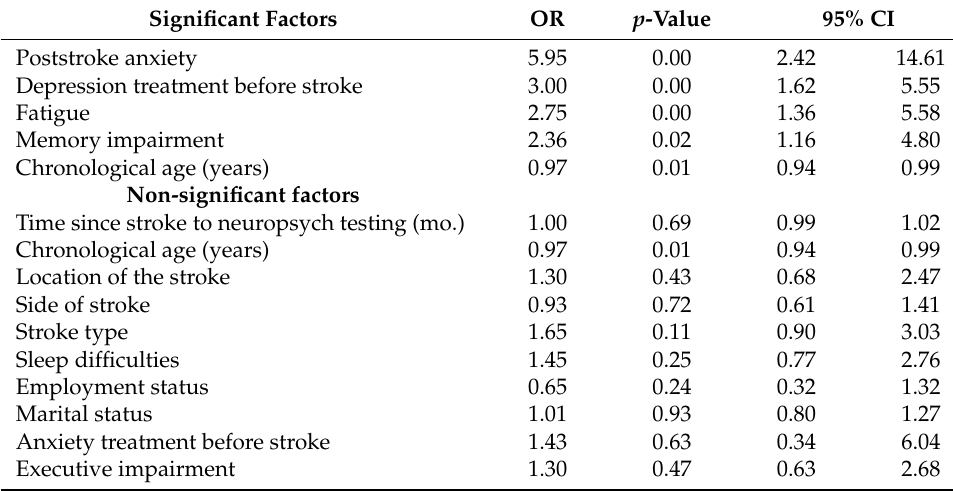
Table 4. Results of the logistic regression analysis indicating poststroke anxiety, history of depression treatment before stroke, fatigue, memory impairment, and younger age were significant associated factors of PSD. Significant Factors OR p